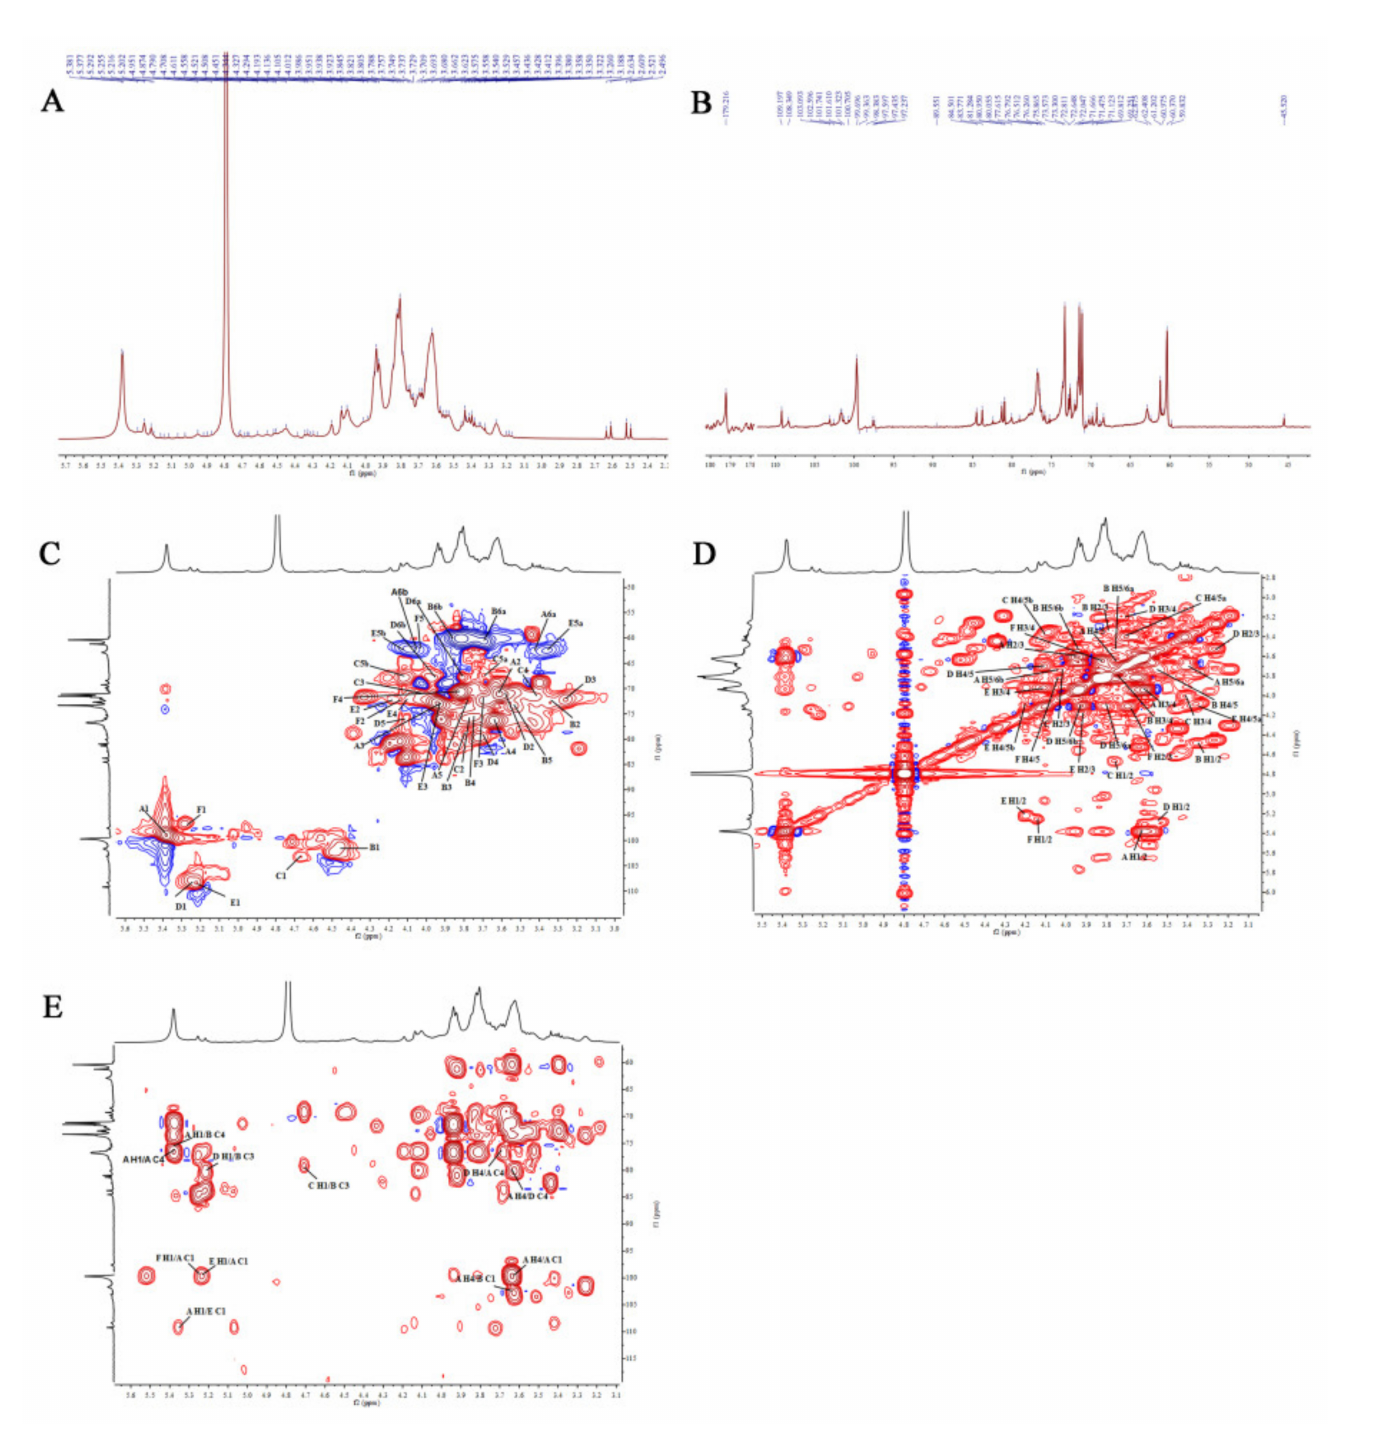
Figure 5. The nuclear magnetic resonance (NMR) spectra of AVPG-1 in deuterium oxide (D 2 O): ( A ) 1 H spectrum; ( B ) 13 C NMR spectrum; ( C ) Heteronuclear single-quantum coherence (HSQC) spectrum; ( D ) 1 H- 1 H correlated spectroscopy ( 1 H- 1 H COSY) spectrum; and ( E ) Heteronuclear multiple-bond correlation (HMBC)